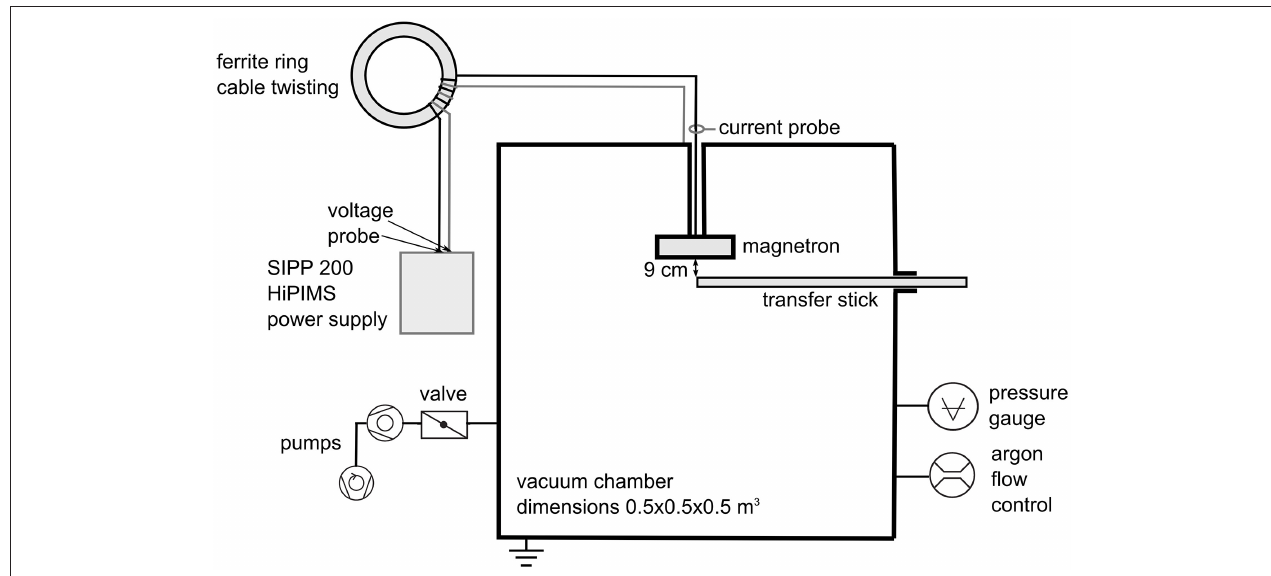
FIGURE 1 | Schematic overview of the experimental set-up. The stainless vacuum chamber is pumped by a combination of a turbomolecular pump combined with a rotary vane pump. The planar cylindrical magnetron is powered by a HiPIMS power supply. A ferrite ring, and cable twisting, were used to reduce any electromagnetic interference. The voltage probe was a Tektronix P1500A (bandwidth 500 MHz). To measure the discharge current, a TCPA300 current transducer was used in combination with a TCP3030 current probe (bandwidth 15 MHz). The voltage and current were recorded with a DSO1024A (bandwidth 200 MHz) oscilloscope. Depositions were performed on silicon substrates introduced in the vacuum chamber through a load